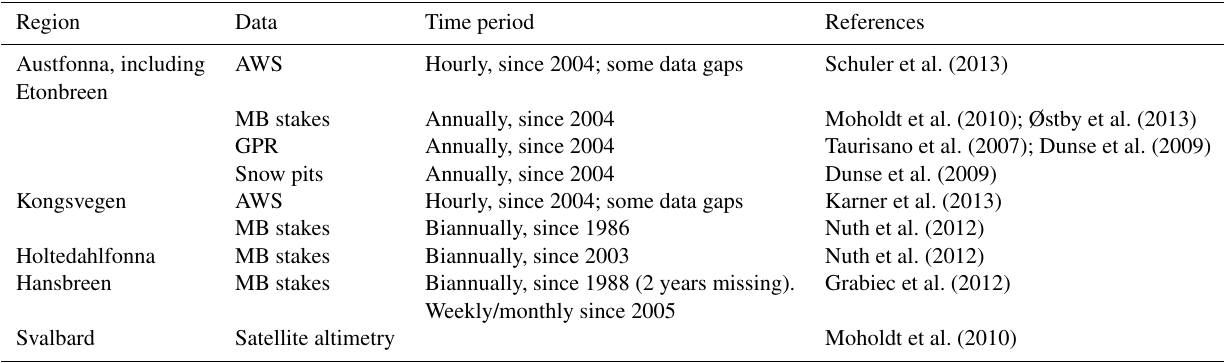
Table 2. Description of observations.